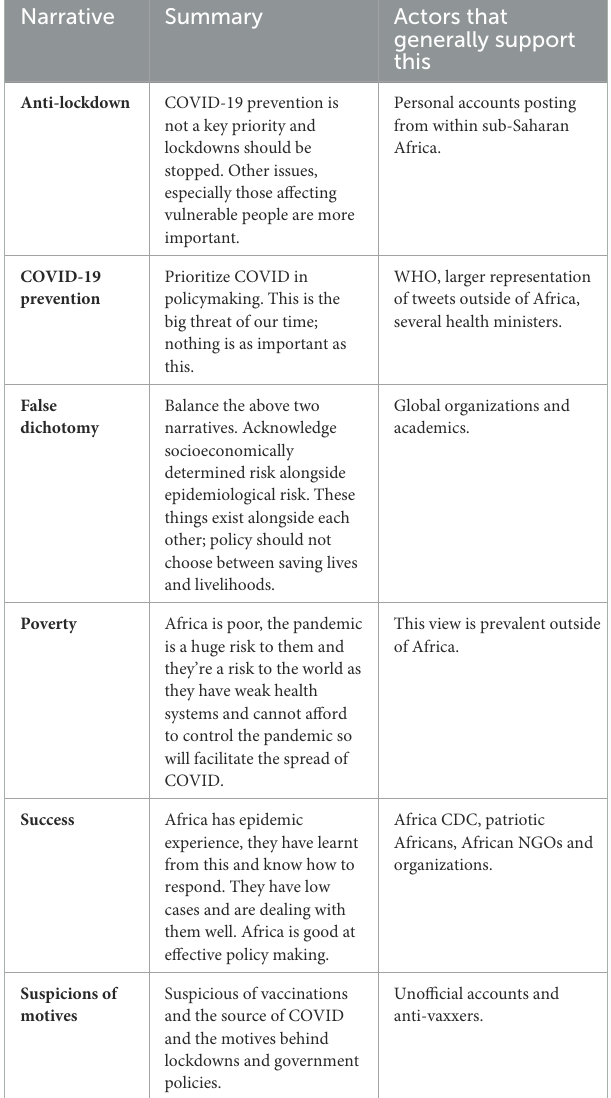
TABLE 1 Summary of the six key narratives.